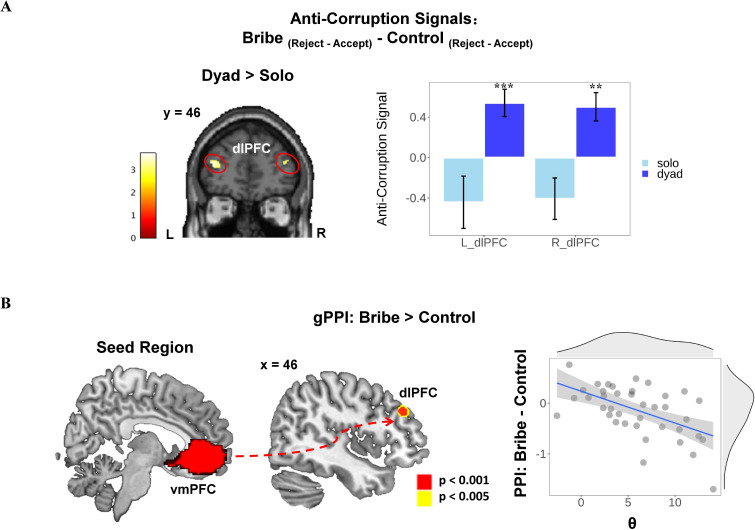
Context-dependent anti-corruption signal and the functional connectivity results.(A) Anti-corruption signal in dorsolateral prefrontal cortex (dlPFC) was specifically enhanced in the Dyad scenario. We defined the anti-corruption signal as the activities (i.e., contrast value) of rejection (vs. acceptance) choice that were specific to the Bribe (vs. Control) condition. Post-hoc analyses on anti-corruption signals within the activated clusters of bilateral dlPFC showed that the interaction was mainly driven by increased anti-corruption signals in the Dyad scenario. Display threshold: voxel-level p (uncorrected) <0.001. Error bars represent the SEM; significance: ***p<0.001. (B) Individual differences in θ negatively modulate the functional connectivity between ventromedial prefrontal cortex (vmPFC) and right dlPFC during bribery-related decision-making (i.e., Bribe vs. Control). The seed region of vmPFC was defined based on a whole-brain parcellation given a meta-analytic functional coactivation map of the Neurosynth database (http://neurovault.org/images/39711/). To visualize the relationship, we extracted the contrast value (cv) of the psycho-physiological interaction regressors of the Bribe and Control conditions within the activated cluster and plotted the correlation between the cv and the individual parameter. Each gray dot represents the data of a single participant; the blue line represents the linear fit using robust correlation (r = −0.54, 95% CI: −0.88,–0.19, p=0.003); the gray density curve indicates the distribution of each variable, respectively.